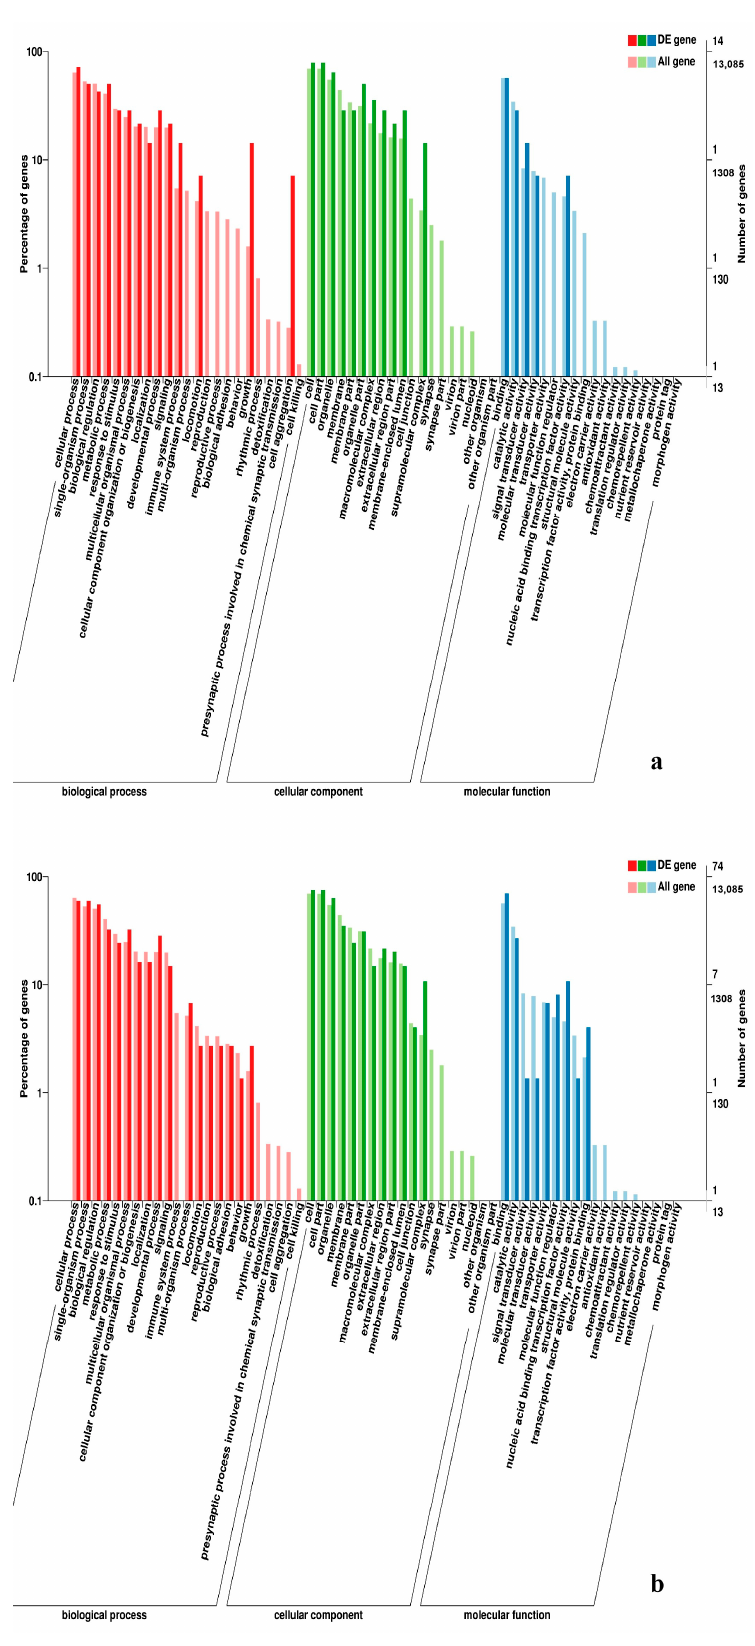
Figure 11. GO enrichment analysis of DEGs in the comparison of breast and leg